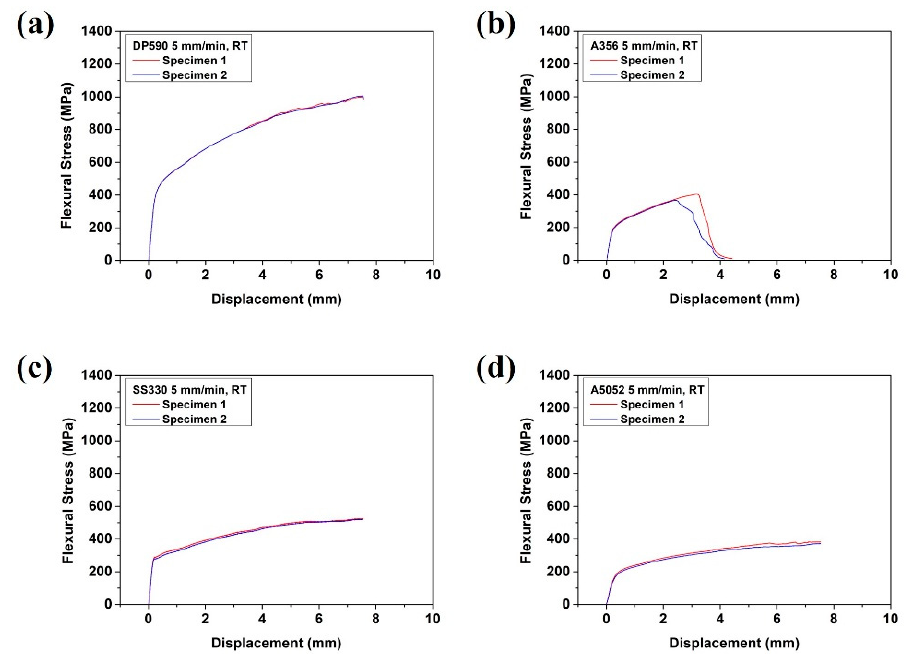
Figure 6. Single-material flexural stress–displacement curves for ( a ) DP590, ( b ) A356, ( c ) SS330, and ( d ) A5052. Table 4. Bending test results of each single material. Flexural Stress at Flexural Stress Maximum Load